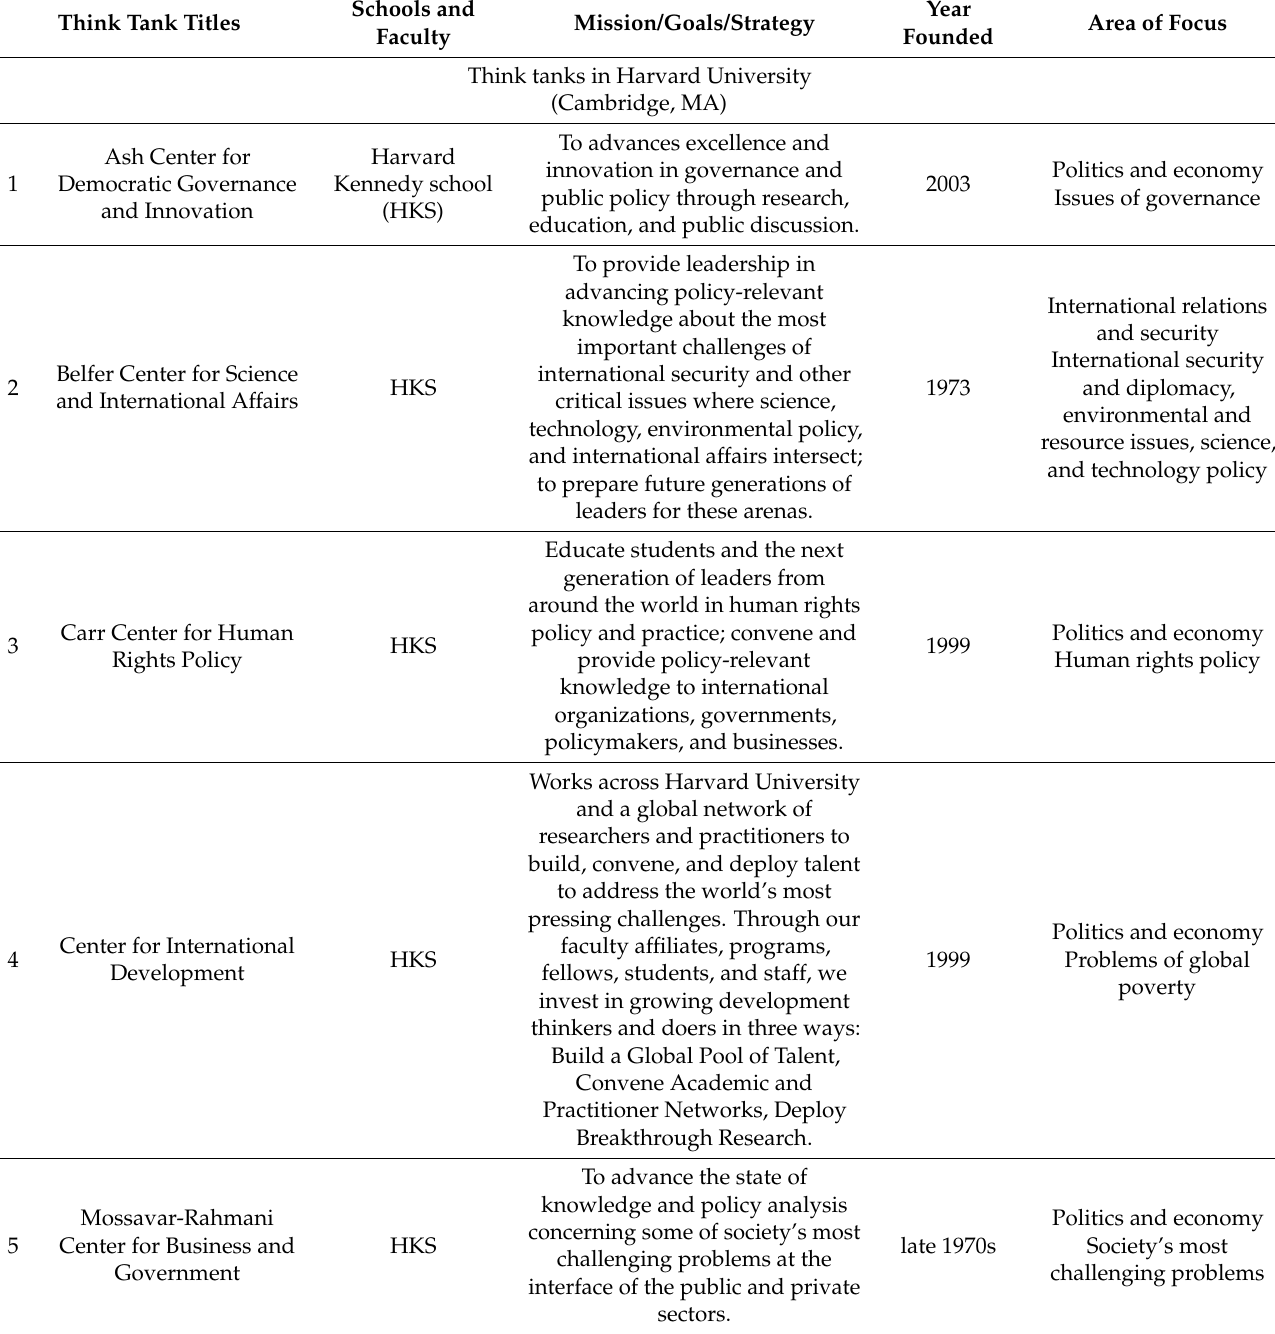
Table 3. The representative Ivy League university think tank